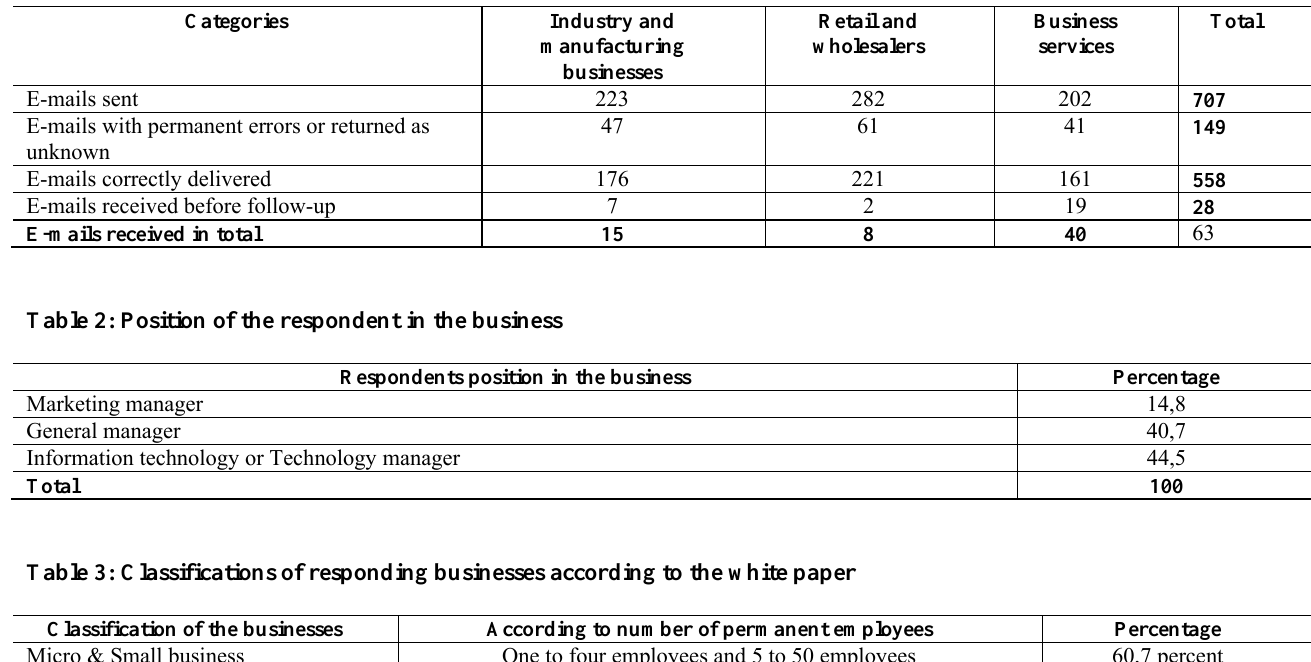
Table 1: Response in empirical study